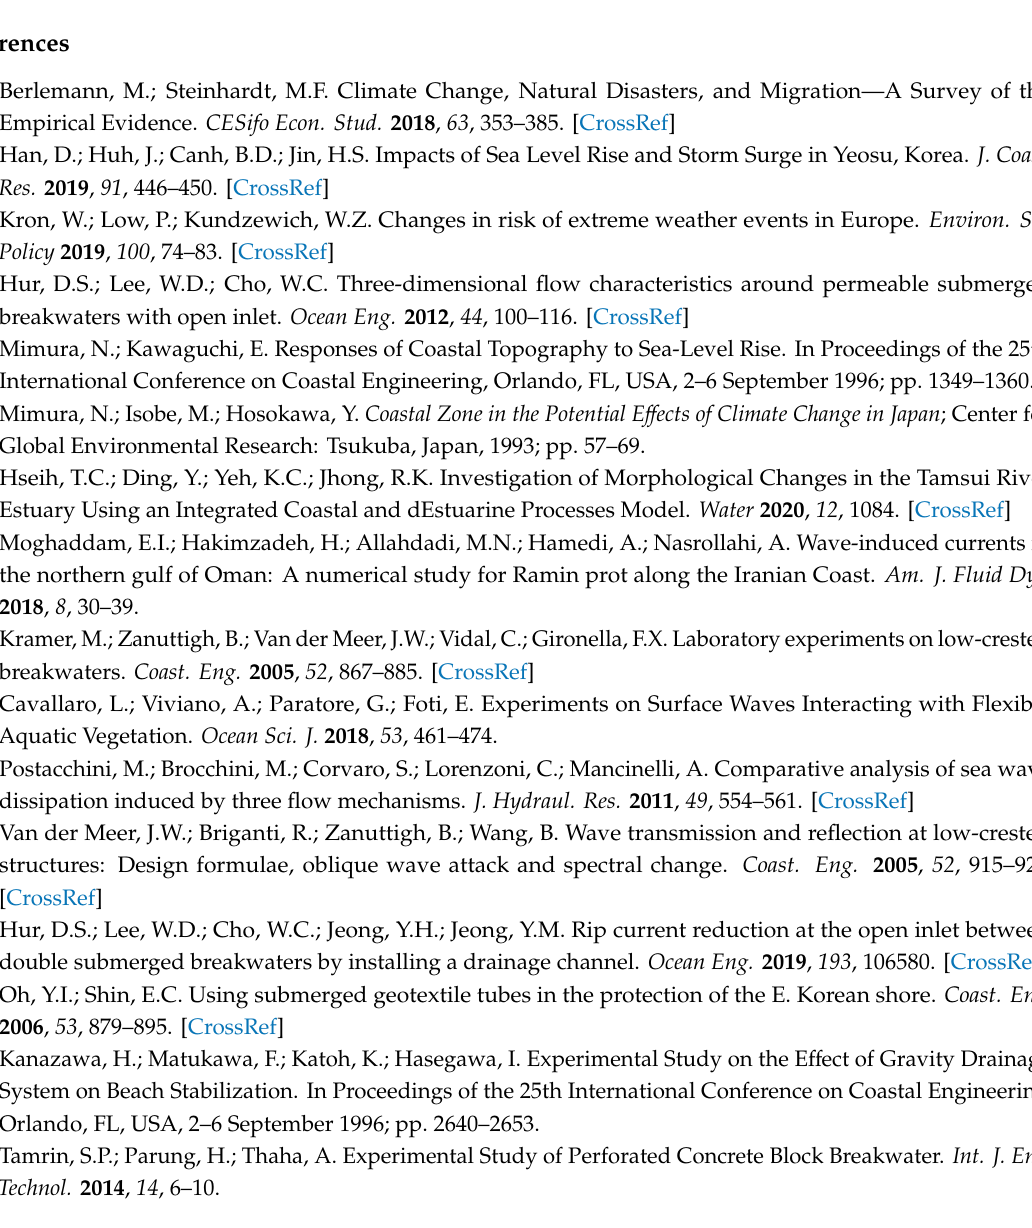
Figure A2. Geometric definition of shoreline (Black and Andrews,